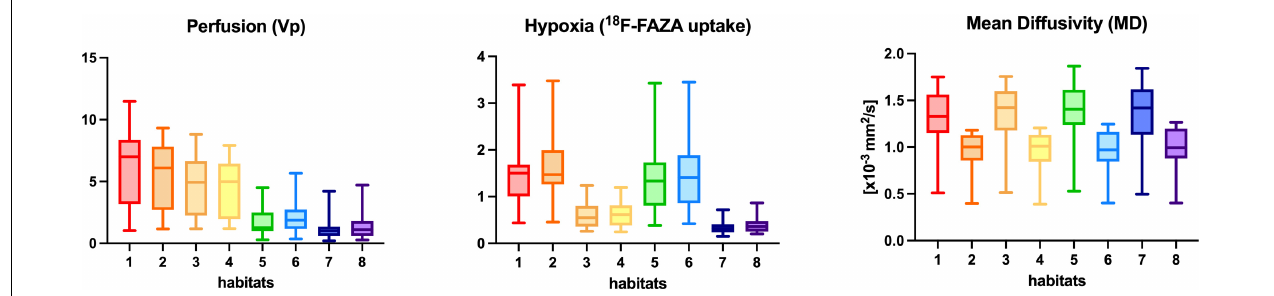
FIGURE 3 | Perfusion (Vp), 18 F-FAZA, and Diffusivity (MD) quantitative values within each habitat for the whole group of patients. Boxplots shows the distribution of mean values of Vp, 18 F-FAZA, and MD parametric maps in each